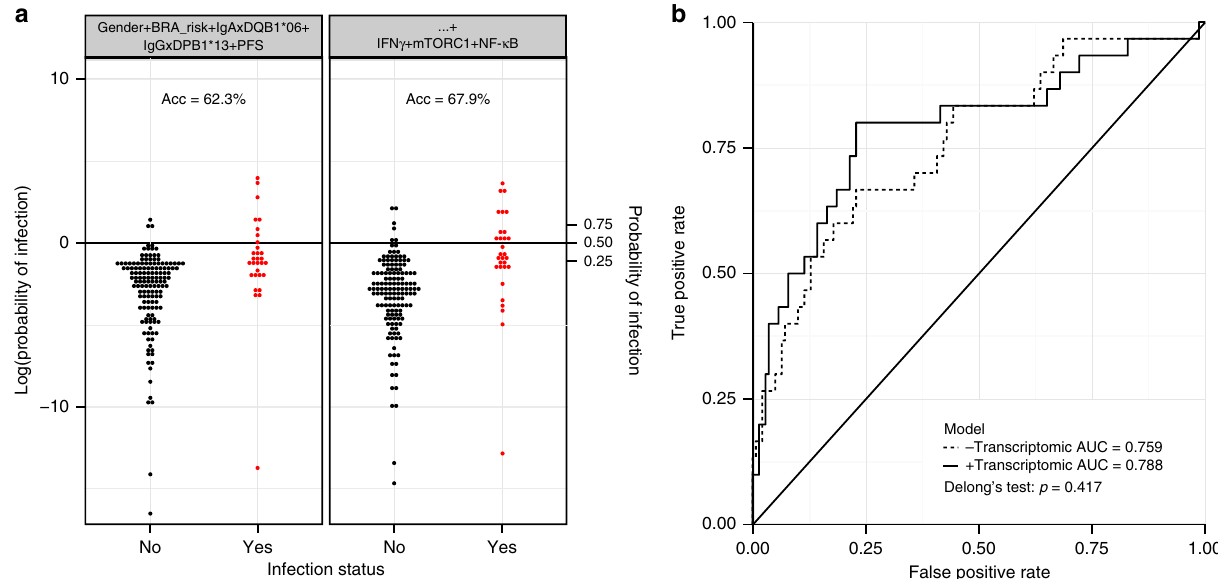
Fig. 4 Prediction of the response does not improve by adding transcriptomic data. a Logistic regression models were built to predict HIV infection status of RV144 vaccinees (142 vaccinees that were HIV negative at last follow-up and 30 vaccinees that acquired HIV). The accuracy of each model was assessed by tenfold cross-validation. The fi rst model (left panel) included IgA against V2, IgG against V1/V2, and the polyfunctionality score (PFS) previously identi fi ed as markers of response to RV144 vaccine. The second model (right panel) included the same markers as the fi rst model but with the addition of the three pathways associated with HIV status in the transcriptomic analysis (IFN γ response, MTORC1 signaling, and TNF α signaling via NF- κ B). The balanced accuracy (Acc) of each model is given on the plot. b Corresponding ROC curves based 10-fold cross-validation for the model without the three genesets and the model with the three genesets identi fi ed in the transcriptomic analysis